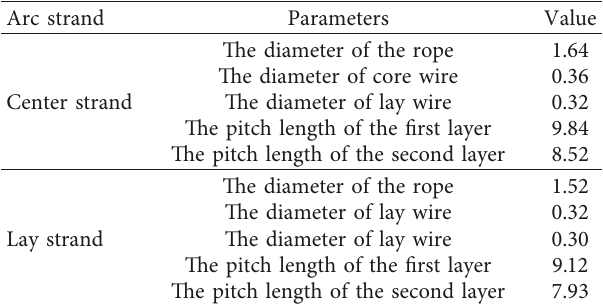
Table 9: The wire rope size parameters used in the GGQ25-62 Polycal WRI [24].